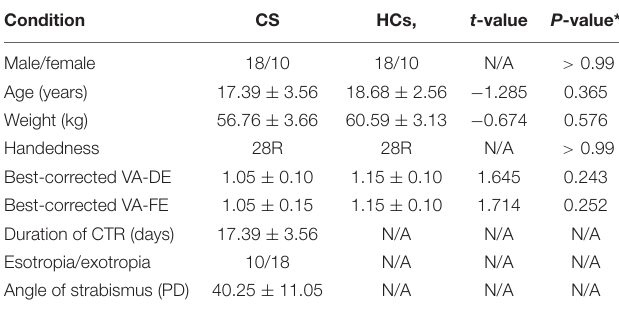
TABLE 1 | The conditions of participants included in the